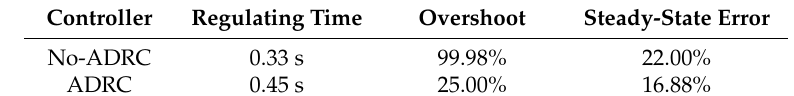
Table 2. Simulation results of q -axis current.